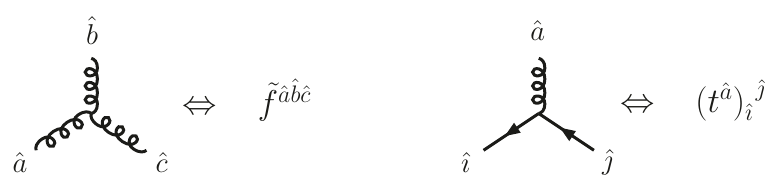
Figure 1 . The two cubic types of interactions for (cid:12)elds in adjoint representation and a generic complex representation. We organize the amplitudes around cubic graphs with these two types of vertices, and the corresponding color factors are contractions of the structure constants and the